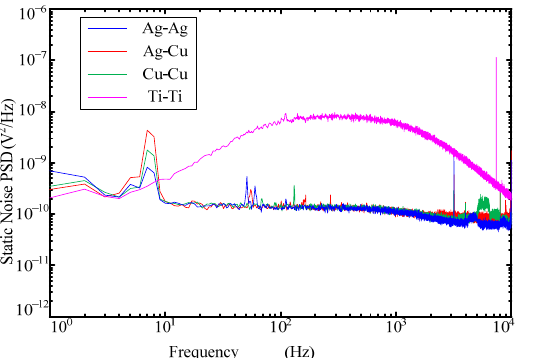
Figure 14. Static noise power spectral density curves of MHD sensors with different material electrode fluid rings.